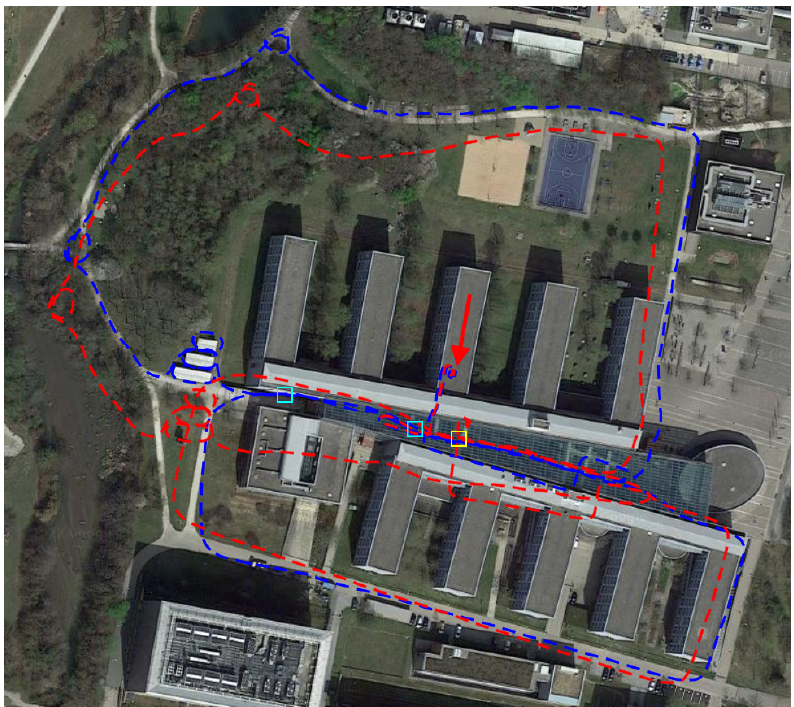
Figure 8. Estimated trajectories by HFNet-SLAM (blue) and ORB-SLAM3 (red) with the outdoors7 se- quence from TUM-VI dataset. Yellow squares denote the places for loop detection by both algorithms, while cyan squares denote the places for loop detection only by HFNet-SLAM. The red pointer points to the start and end of trajectories according to the ground truth